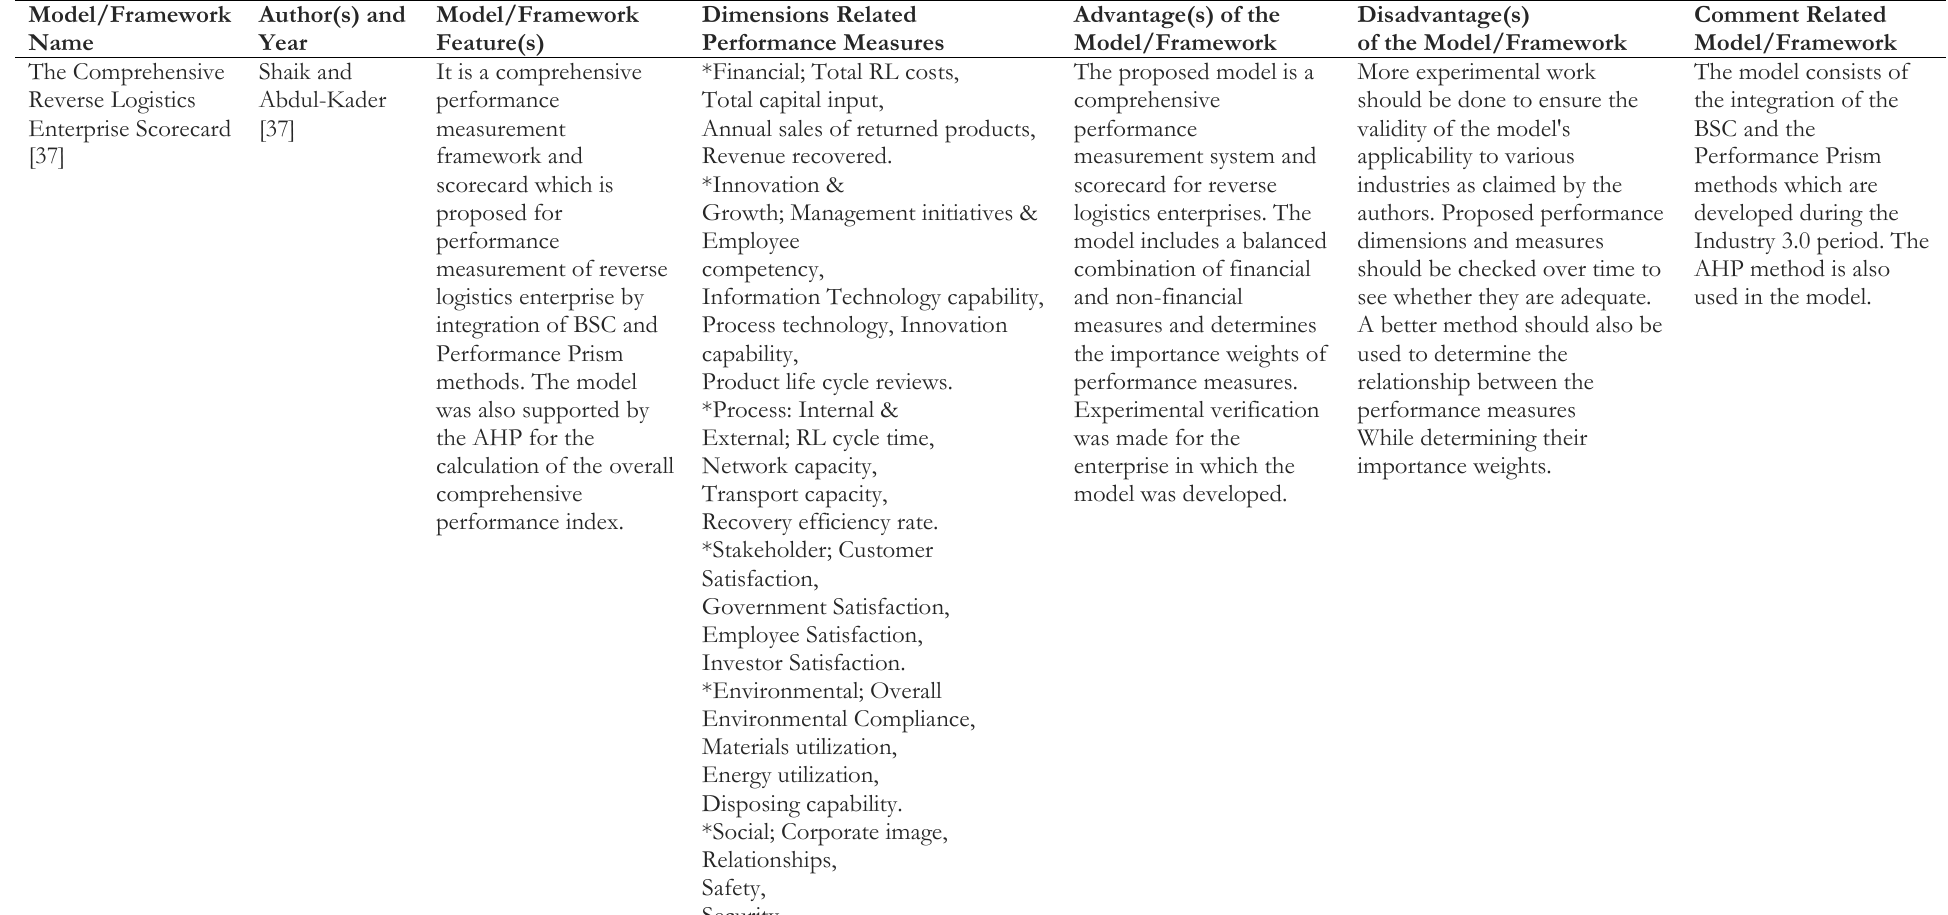
Table 15. Organizational performance measurement models developed in Industry